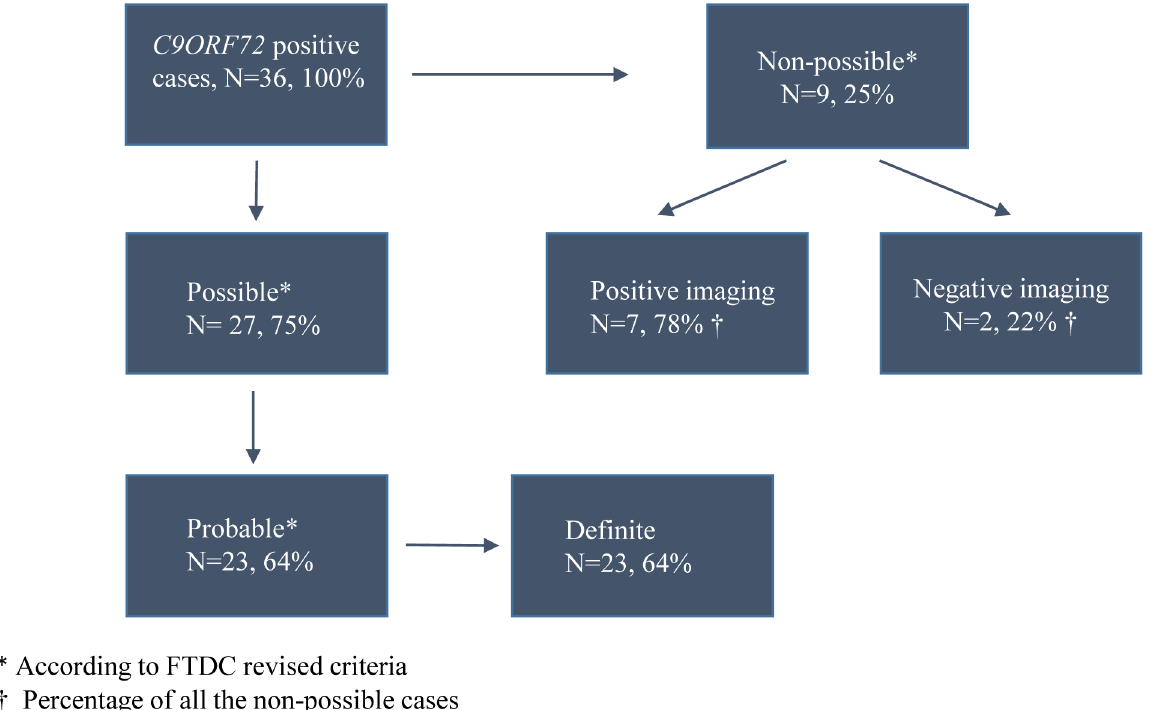
Fig 1. Flow chart of the study. Thirty-six patients with the C9ORF72 expansion were examined. Seventy-five percent (N = 27) of the study participants met the possible FTDC criteria and 64% (N = 23) met the probable FTDC criteria. Altogether 25% did not meet FTDC possible criteria. Seventy-eight percent of them (N = 7) had positive neuroimaging result and 22% (N = 2) had negative neuroimaging result for